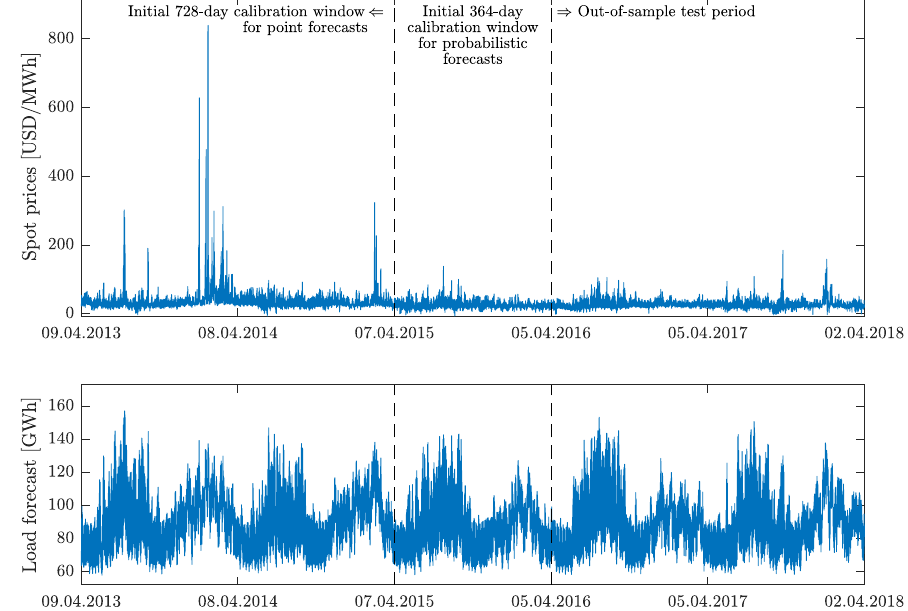
Figure 2. PJM hourly system prices ( top ) and hourly load forecasts ( bottom ) in the Commonwealth Edison (COMED) zone from 9 April 2013 to 2 April 2018. The first dashed line marks the beginning (7 April 2015) of the initial 364-day calibration window for probabilistic forecasts, the second—the beginning (5 April 2016) of the 728-day long out-of-sample test